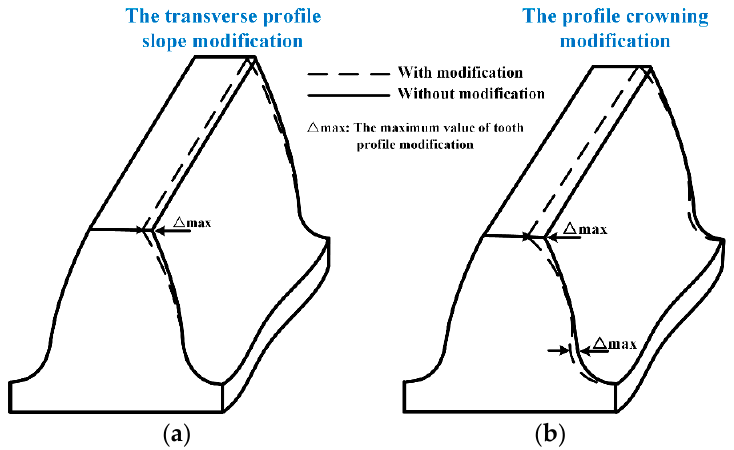
Figure 3. ( a ) The schematic diagram of a beveloid tooth with a transverse profile slope modification and ( b ) profile crowning modification (Reprinted with permission from [37]. Copyright 2018 Elsevier).